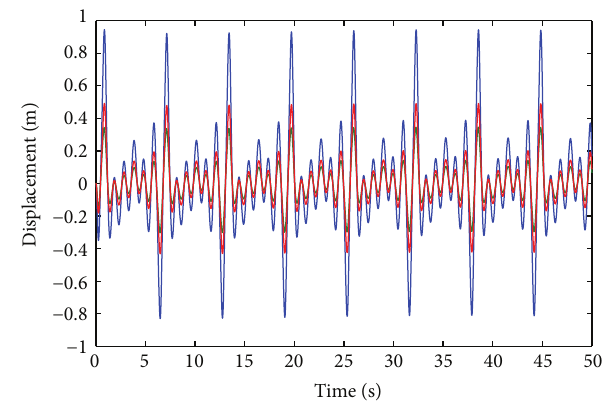
Figure 4: Displacement